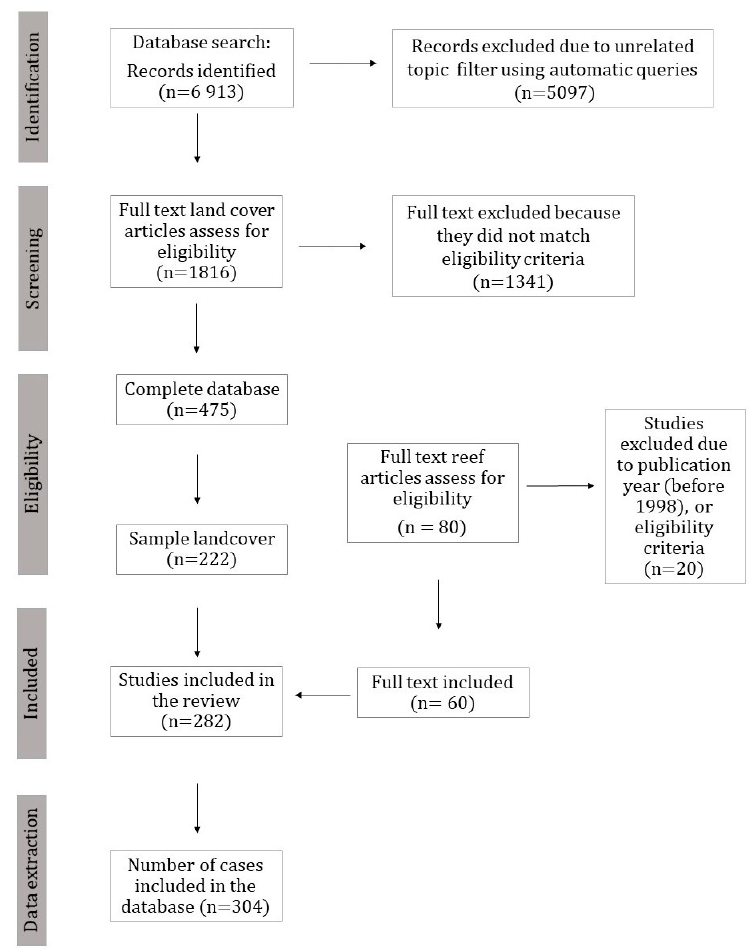
Figure 1. Flow diagram outlining the publication selection process and actions to include in the